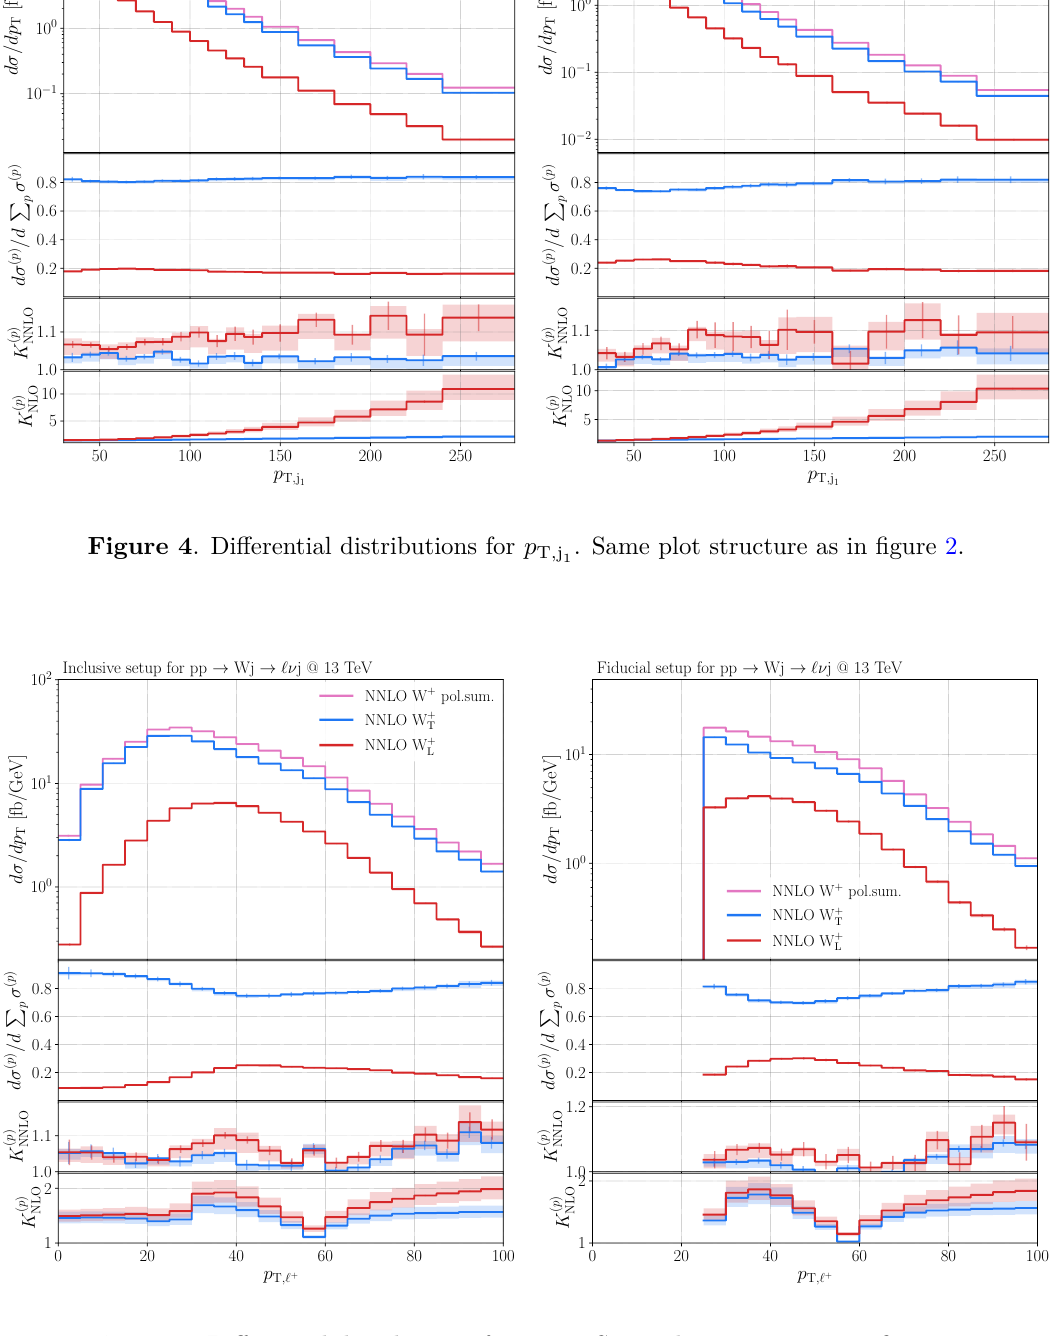
Figure 5 . Differential distributions for p